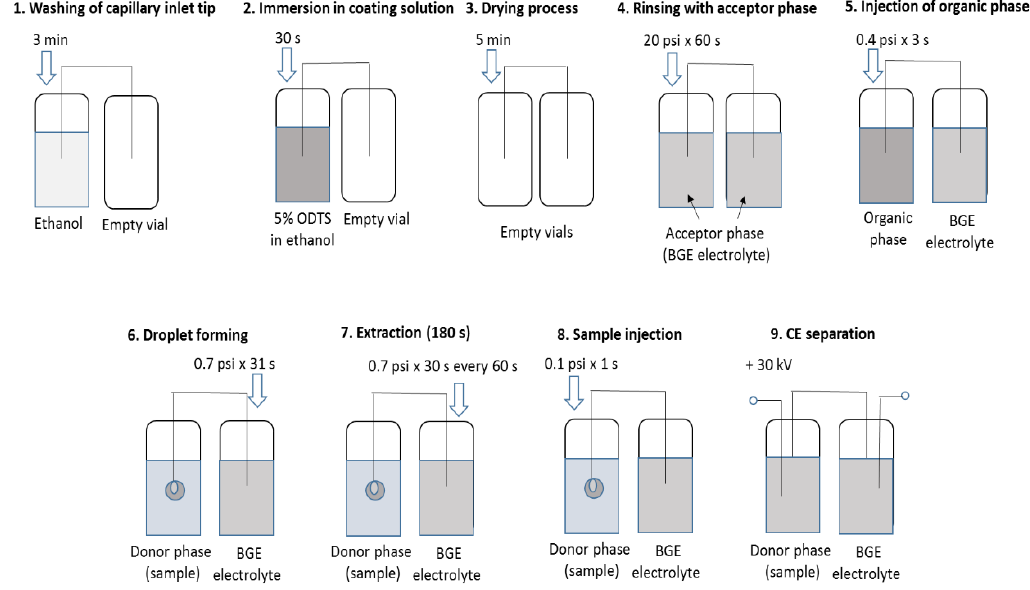
Figure 6. Scheme of SDME-CE procedure.